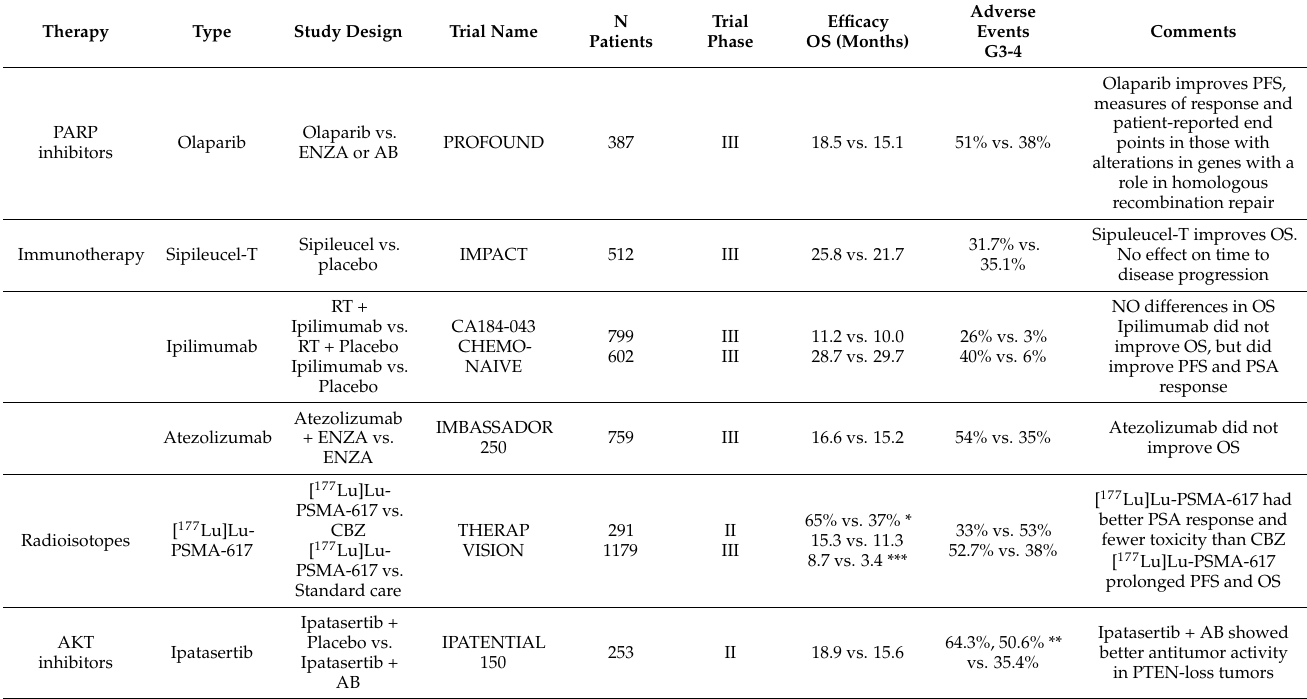
Table 2. Emerging therapies in